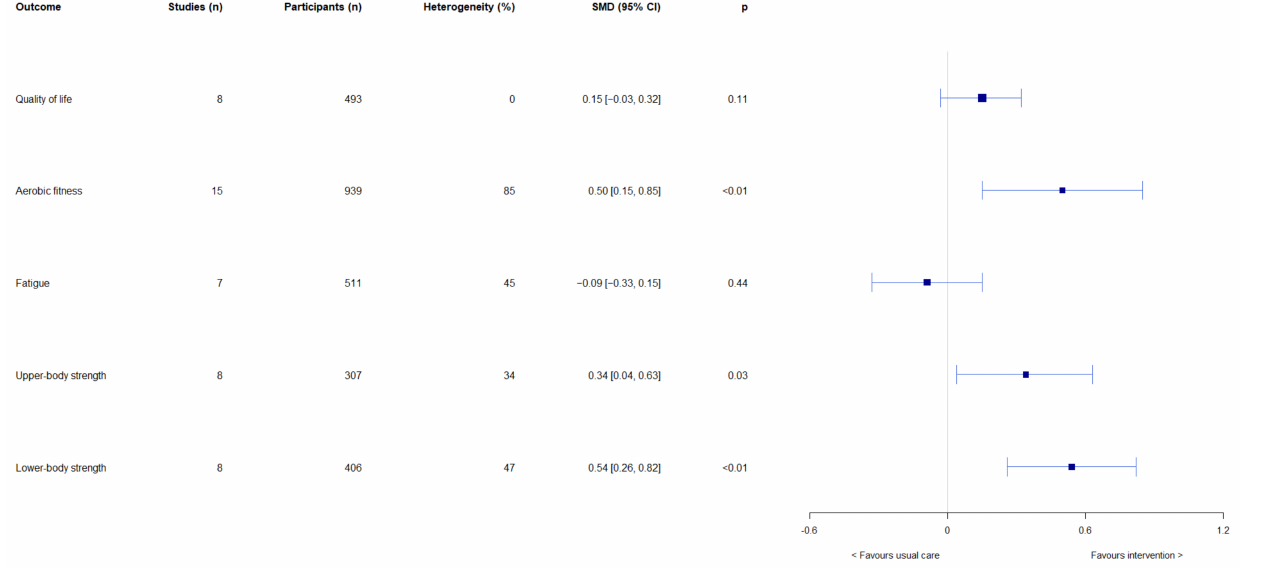
Figure 2. Results of meta-analyses on the overall effects on quality of life, aerobic fitness, fatigue, upper-body strength, and lower-body